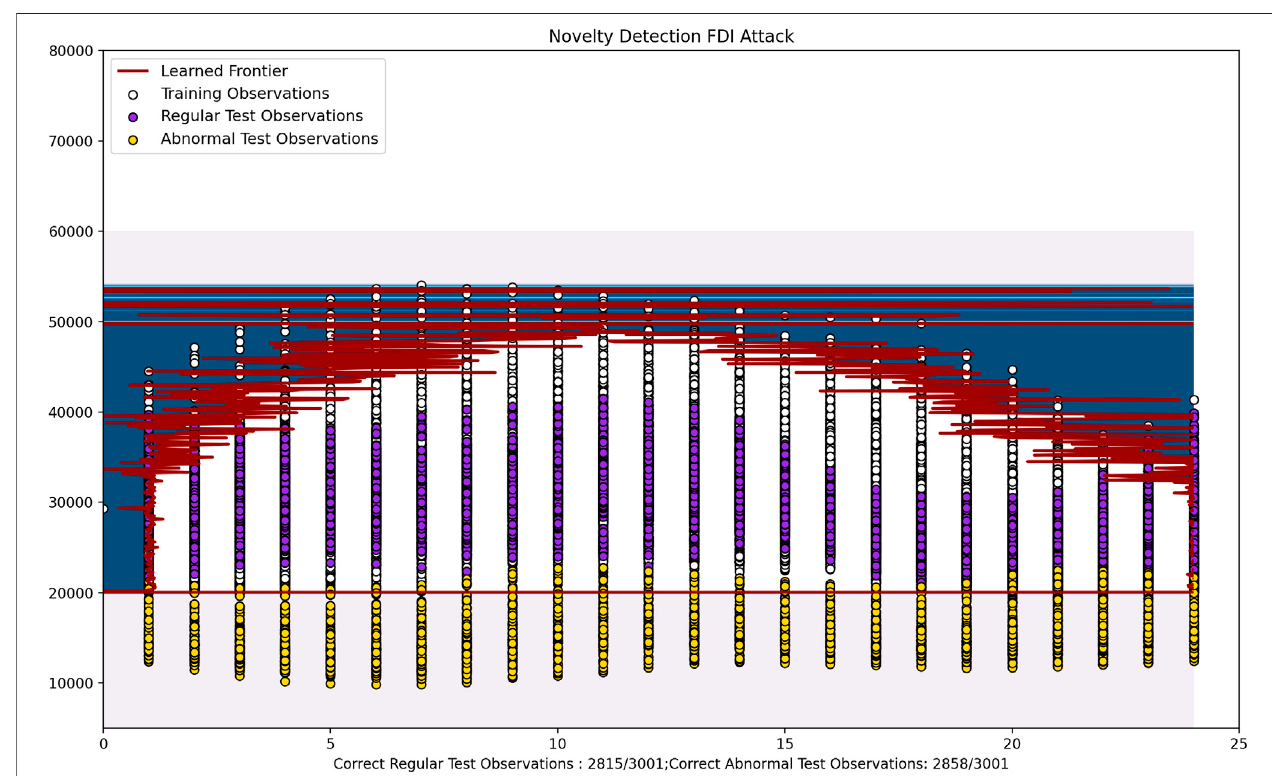
FIGURE 14 | OC-SVM on third cluster.